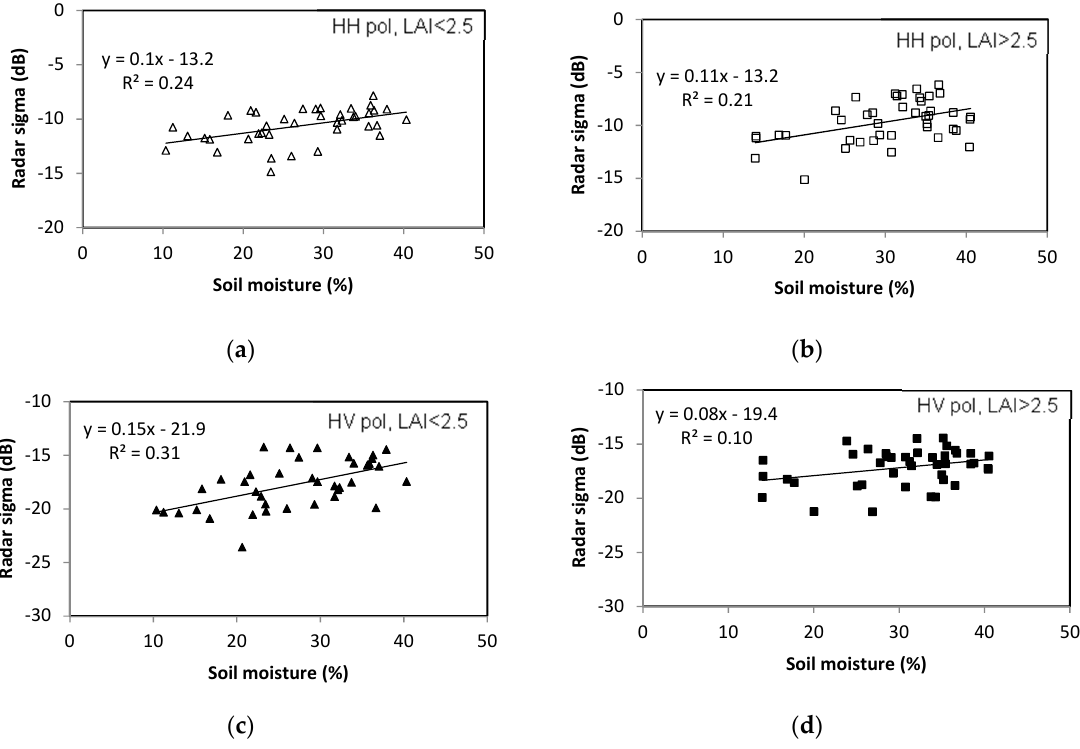
Figure 7. PALSAR radar data as a function of soil moisture for marigold cover: ( a ) HH polarization, LAI <2.5; ( b ) HH polarization, LAI >2.5; ( c ) HV polarization, LAI <2.5; ( d ) HV polarization, LAI >2.5.